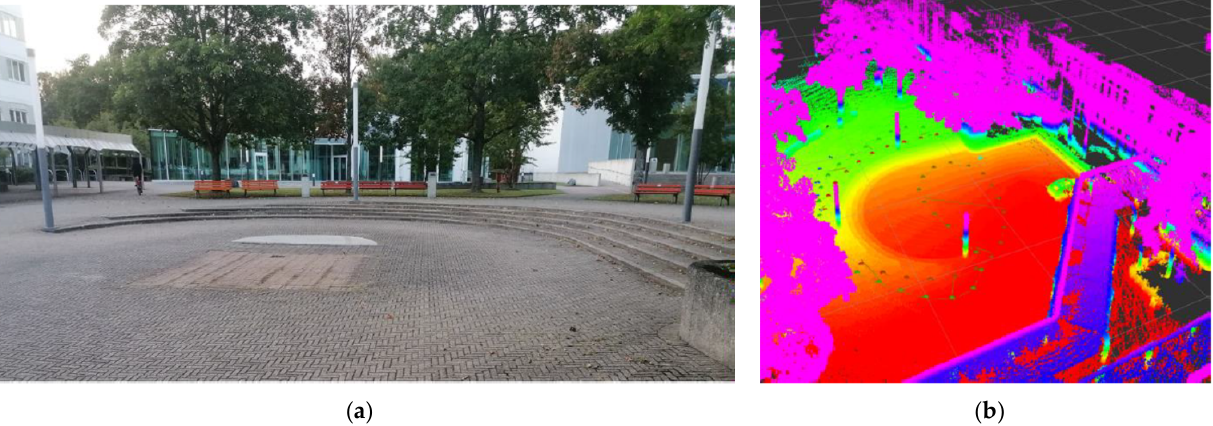
Figure 16. ( a ) Test track. ( b ) Map of the entrance area of the B-building created using hdl_graph_slam.